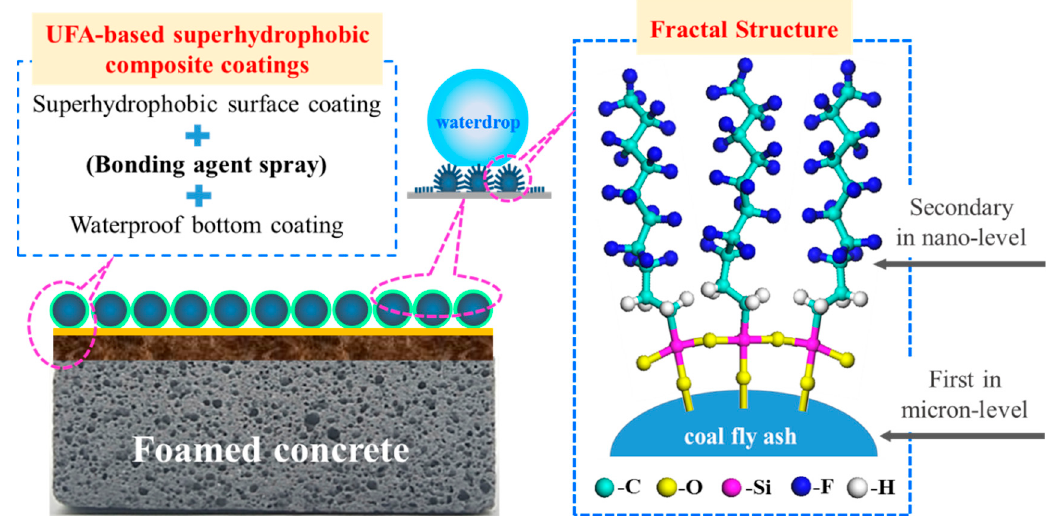
Figure 15. Construction of the UFA-based superhydrophobic composite coating.